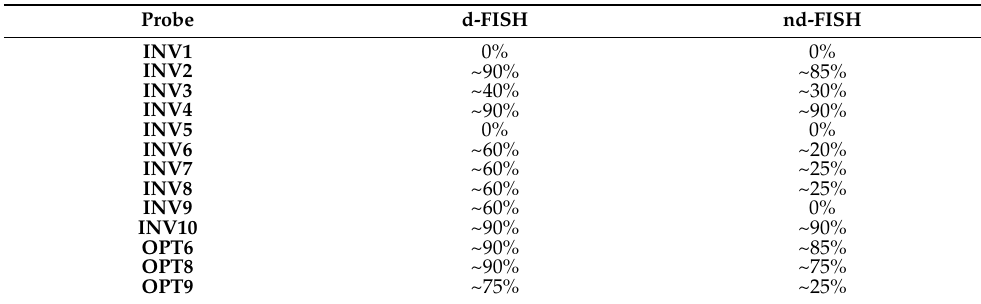
INV2 , INV4 , and INV10 (upper, middle and lower panels, respectively) were incubated with isolated nuclei from a bovine kidney cell line under denaturing (5 min, 80 ◦ C, left) or non-denaturing (3 h, 37.5 ◦ C, right) conditions. Fixed isolated nuclei were incubated with probes in a Tris buffer (20 mM of Tris-Cl, 100 mM of KCl, pH 8.0) and counterstained with DAPI. The images were obtained by overlaying Cy3 (red) and DAPI (blue) filter settings and adjusting the exposure. Nuclei are viewed at 60 × magnification using a Nikon Eclipse T i -S inverted microscope. The scale bar represents 16 µ m. For corresponding images for other Invader probes, see Figures S14–S17. Table 5. Percent of nuclei presenting a single, punctate signal in d-FISH and nd-FISH assays when incubated with different Invader probes a . Probe